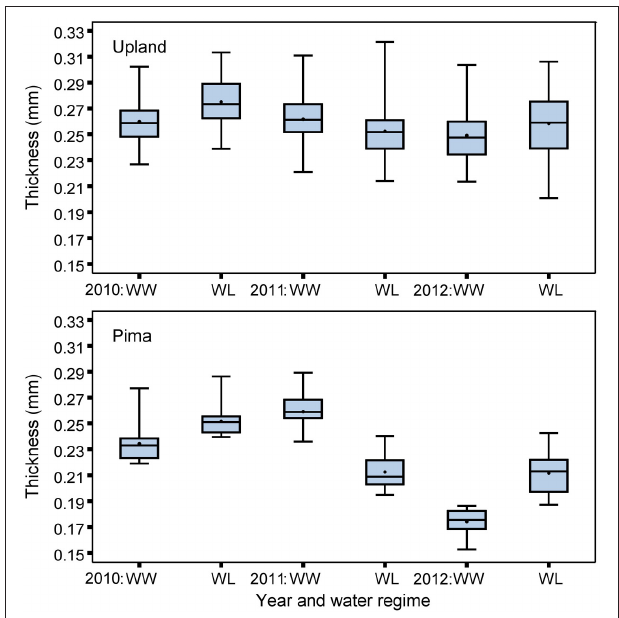
FIGURE 2 | Boxplots of BLUEs for leaf thickness measured with micrometer for the upland recombinant inbred lines and Pima lines, considering well-watered (WW) and water-limited (WL) irrigation regimes in 2010, 2011, and